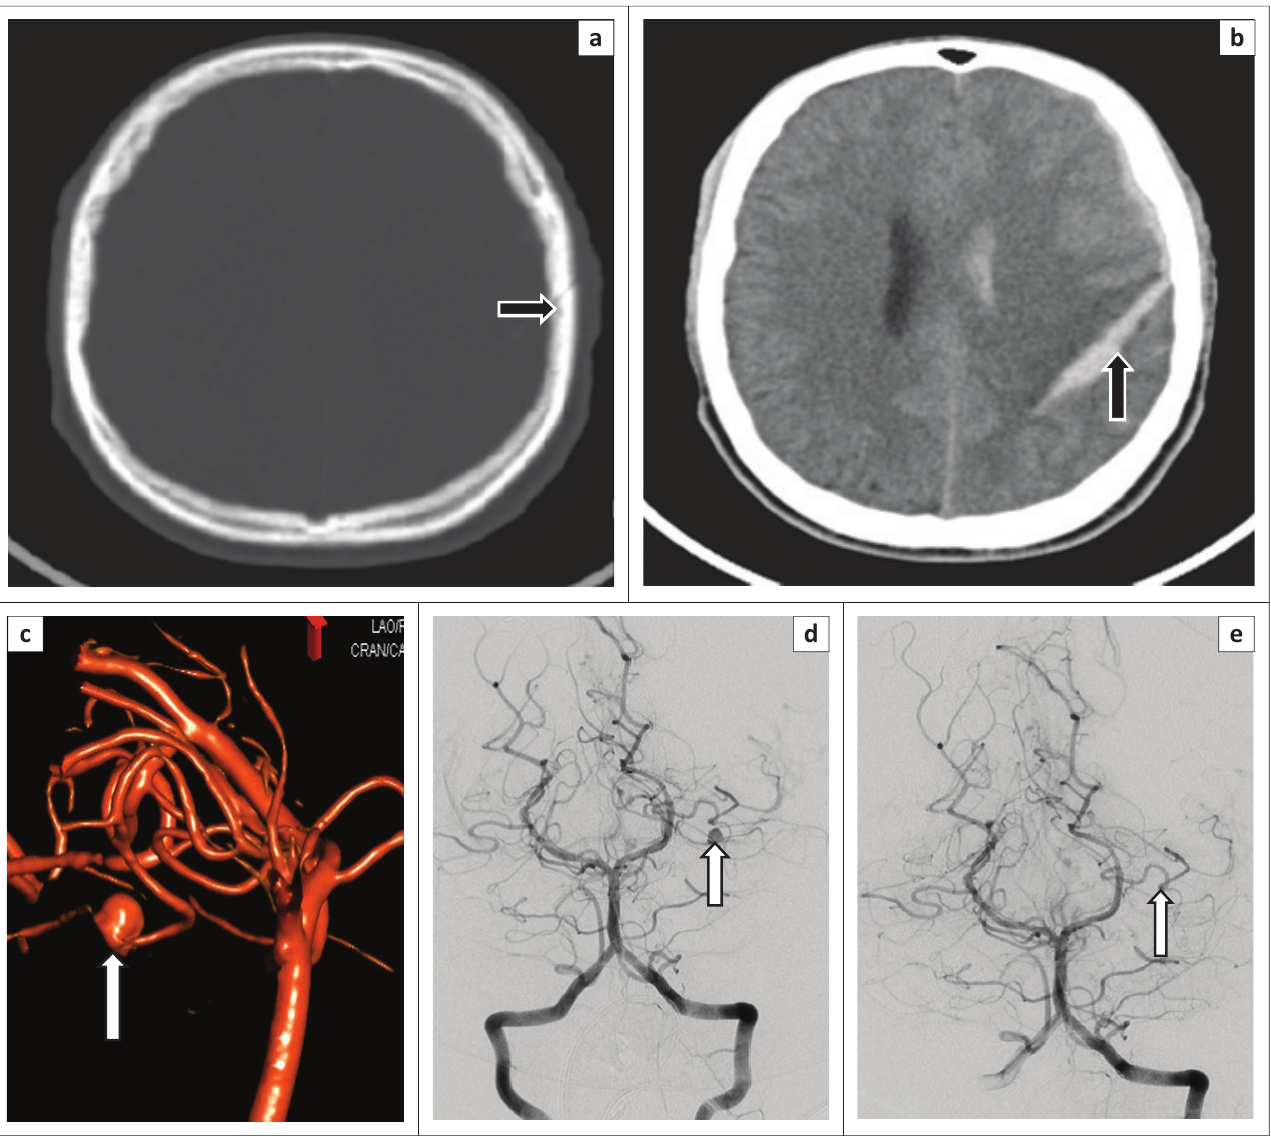
FIGURE 1: (a) Computed tomography (CT) scan (bone window) showing a slot fracture with complete calvarial penetration, (b) CT scan of the brain showing a tract haematoma, (c) Three-dimensional reconstruction from the digital subtraction angiography (DSA) showing a traumatic pseudoaneurysm, (d) DSA showing a traumatic pseudoaneurysm before endovascular intervention and (e) DSA done following parent vessel occlusion showing complete exclusion of the